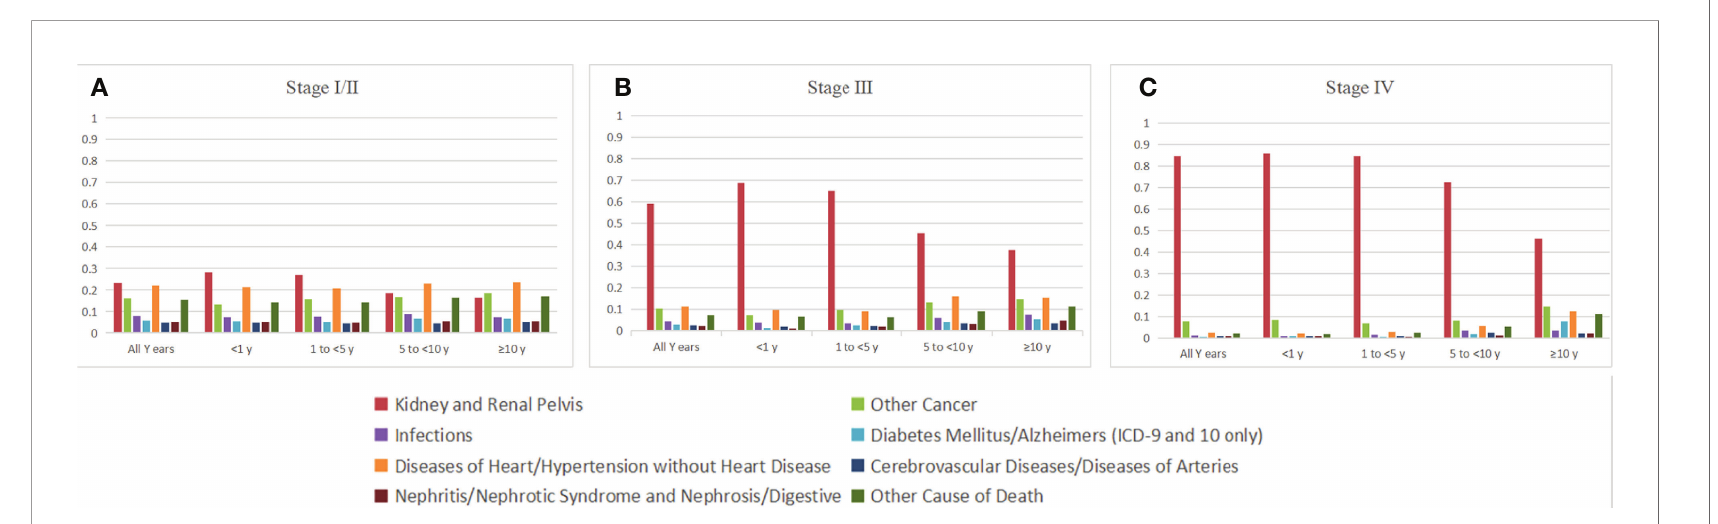
FIGURE 2 | Causes of death by stage after the diagnosis of RCC; (A) stage I/II, (B) stage III, (C) stage